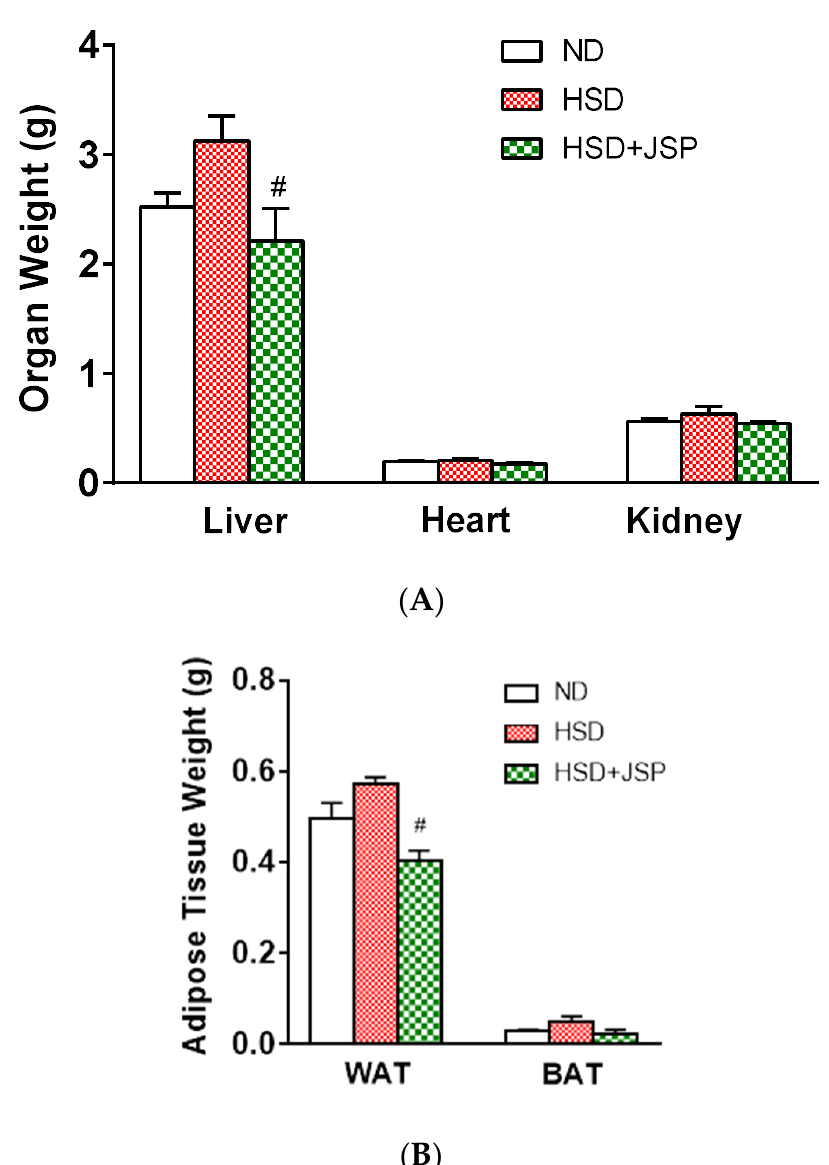
Figure 4. JSP supplementation significantly reduced liver weight and the weight of WAT. ( A ) Weight of Liver, Heart, and Kidney; ( B ) Weight of white adipose tissue (WAT) and brown adipose tissue (BAT). ND: Normal Diet; HSD: High-Sugar Diet; and JSP: Jackfruit Seed Powder. # p < 0.05 vs. HSD by one-way ANOVA followed by Tukey’s post hoc test. Bars represent mean ± SEM. n ≥ 3 for each group.